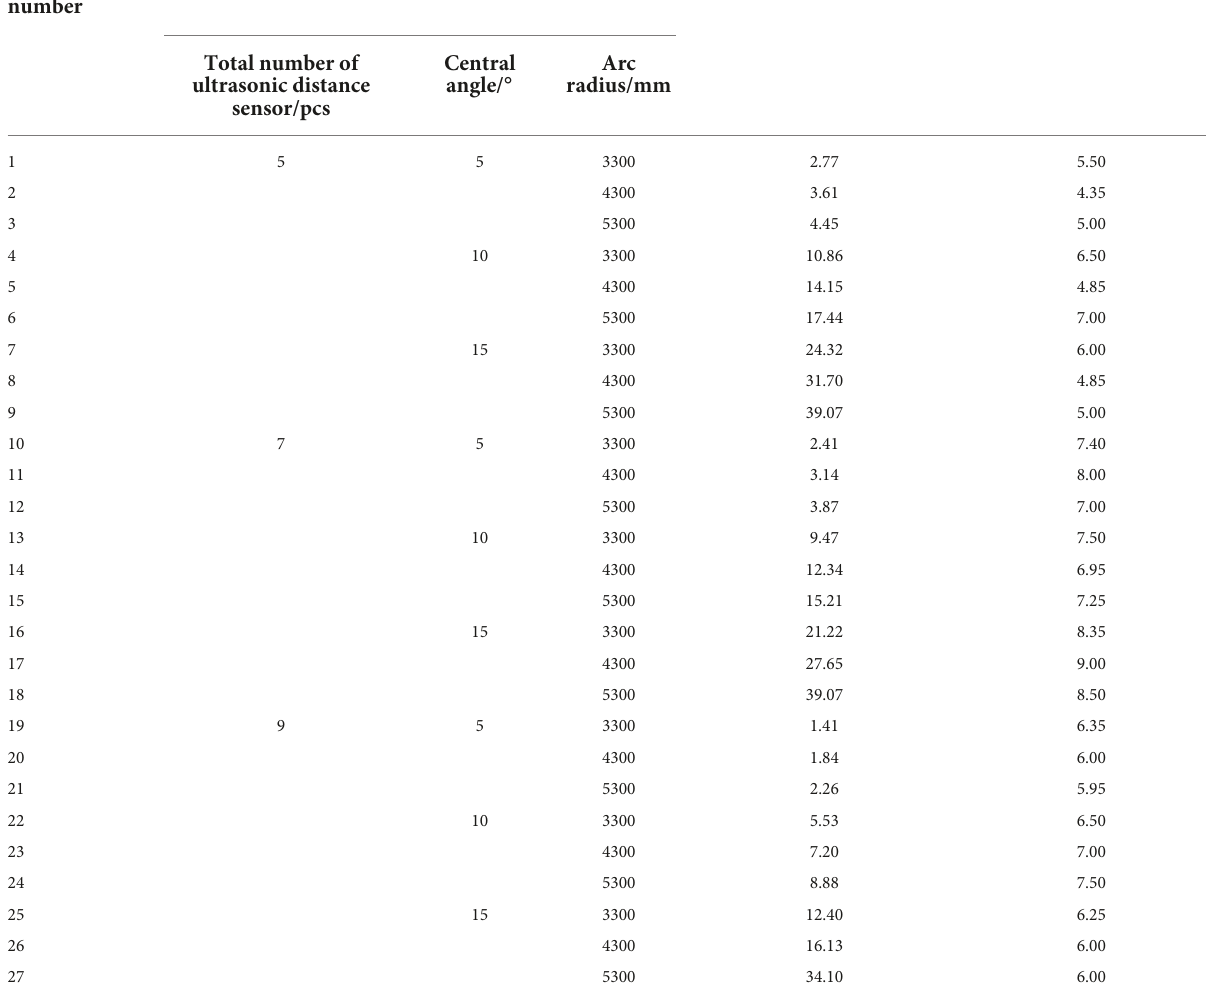
TABLE 5 Multi-factor coupling affects the accuracy of lateral deviation